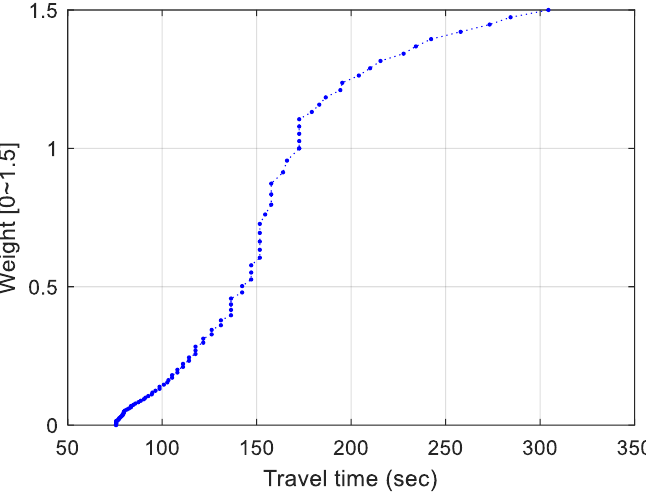
Figure 5. Results of weight versus time. Table 6. Comparison of single-weight and multi-weight calculation results .